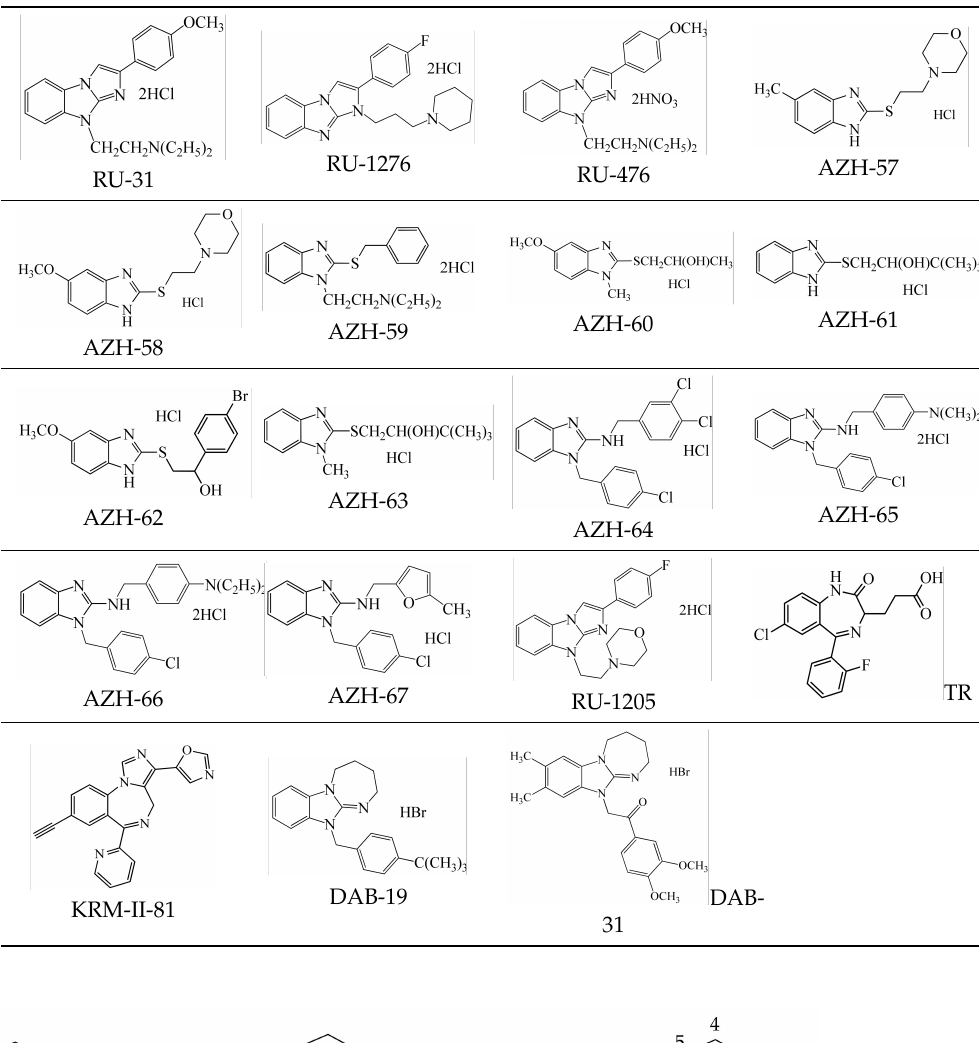
Table 1. Chemical structures of described